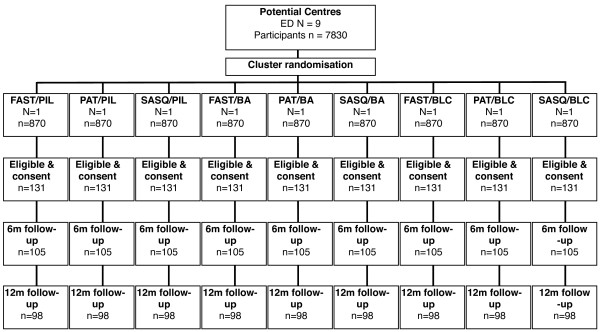
Trial Flow Chart.